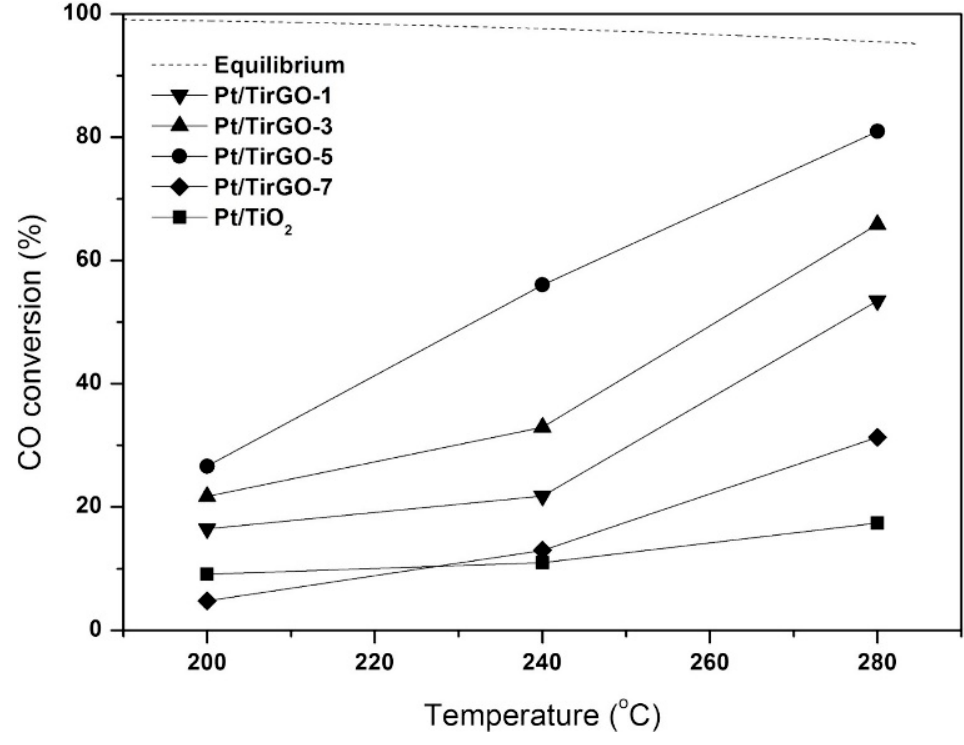
Figure 6. CO conversions in water gas shift (WGS) reaction with Pt/TirGO catalysts and Pt/TiO 2 (S/C ratio = 3.3, GHSV = 47,700 h − 1 ), reproduced from [42], with permission from Elsevier, 2017.